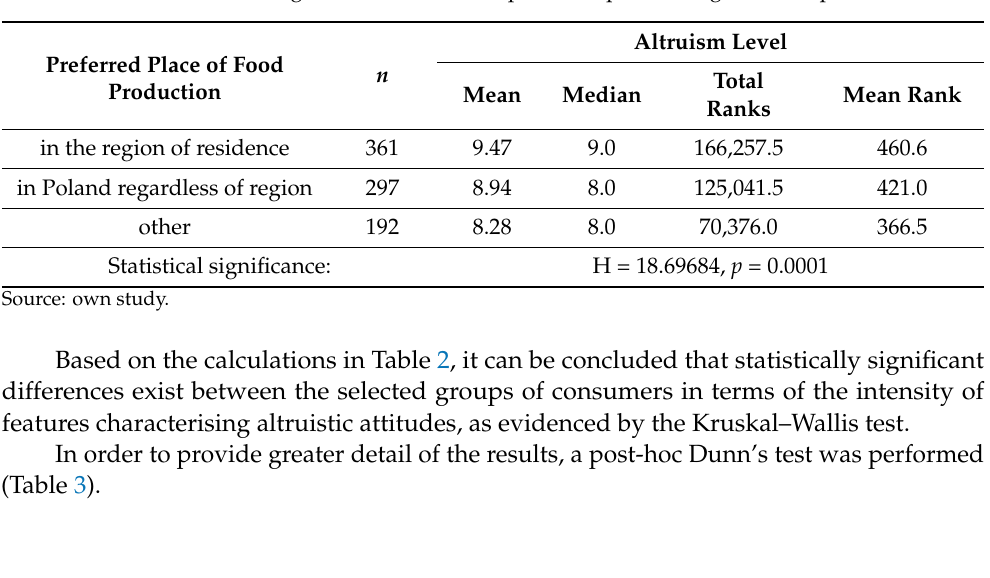
Table 2. Altruism level among consumers vs. their preferred place of organic food